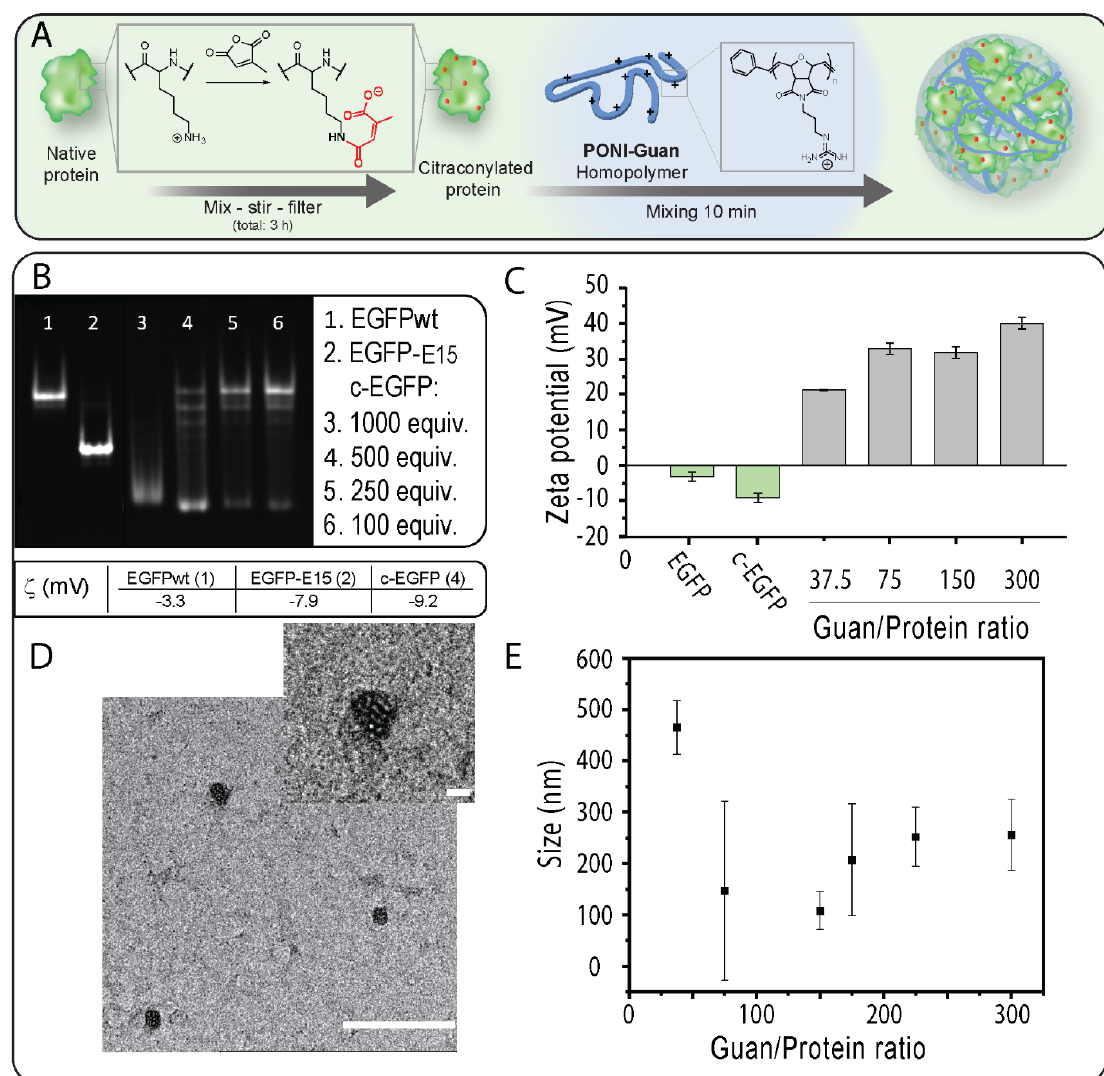
Figure 1. ( A ) c − EGFP can form nanocomposites by self-assembly with a cationic PONI Guan polymer. ( B ) A total of 12% native PAGE analysis of unmodified EGFP, polyglutamate-tagged EGFP (EGFP-E15), and c − EGFP. ( C ) Zeta potential of uncomplexed EGFP and c-EGP, and of nanocomposites at varying Guan/Protein ratios. ( D ) A TEM image of nanocomposites. The scale bar = 500 nm and the inset scale bar = 100 nm. ( E ) Size measurements of nanocomposites at varying Guan/Protein ratios. Data are an average of repeated measurements (n =